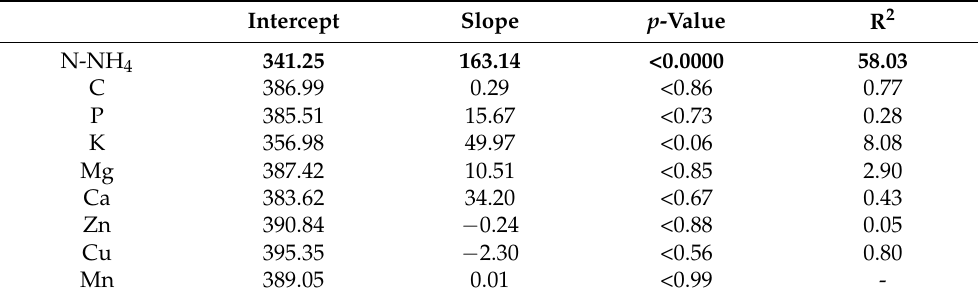
Table 6. Results of linear regression analyses describing the relationship between maize yields and nutrient dose in the pot